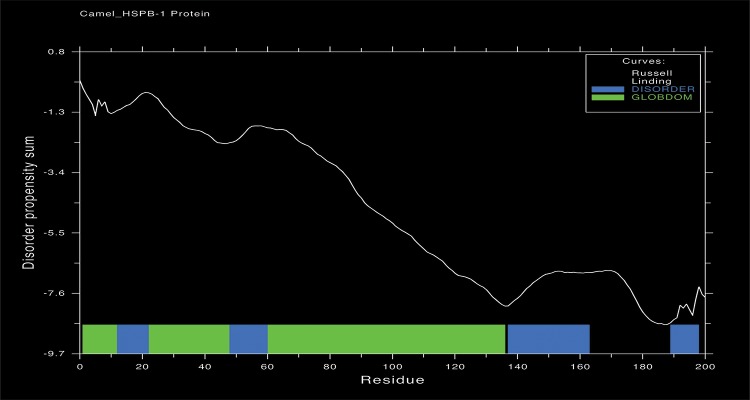
Glob Plot analysis.Blue boxes are disordered regions, and green boxes are ordered regions in the Arabian camel HSPB-1 protein.